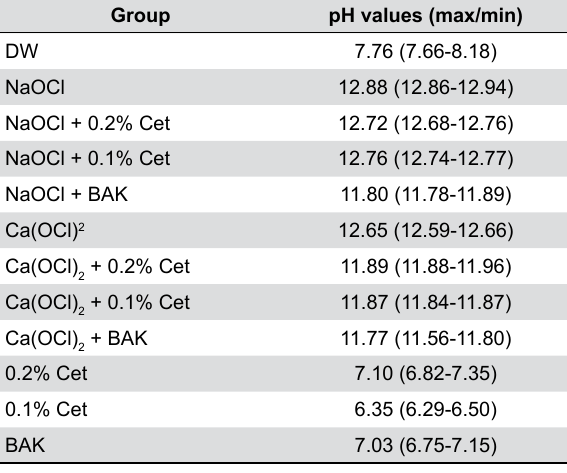
Table 1- pH readings of tested solutions (median, maximum and minimum values)